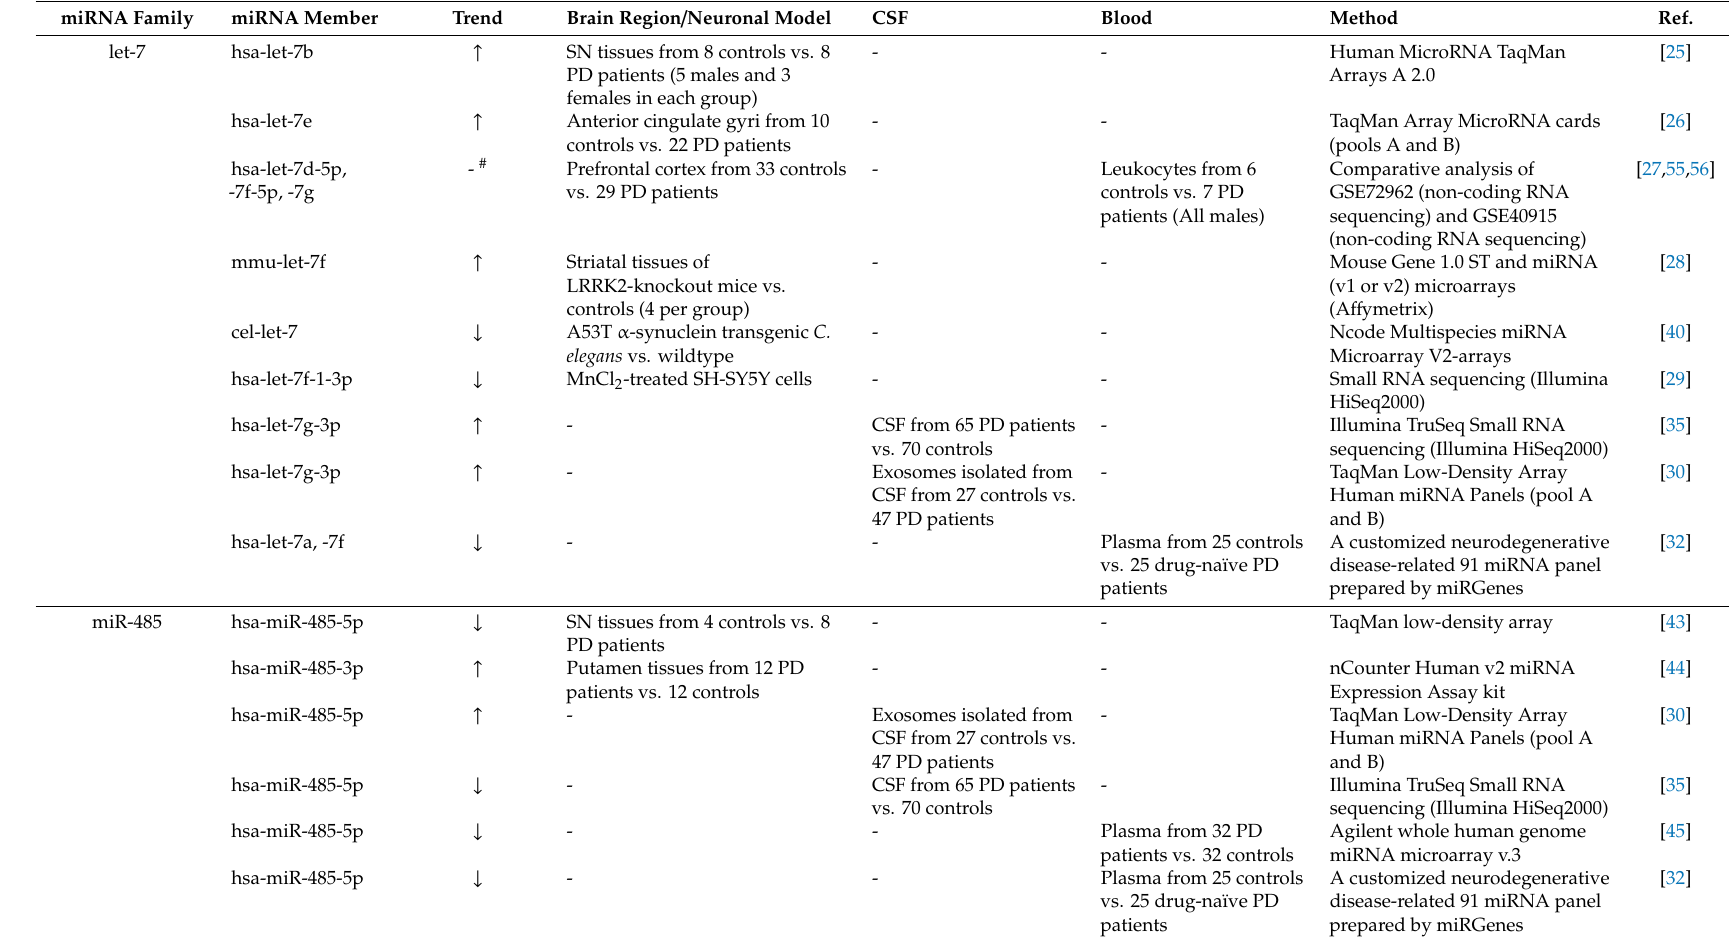
Exosomes isolated from CSF from 27 controls